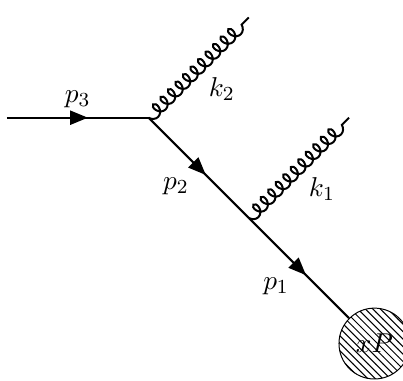
Figure 1 . Kinematics of double soft gluon emission, in the angular ordered parton shower, for